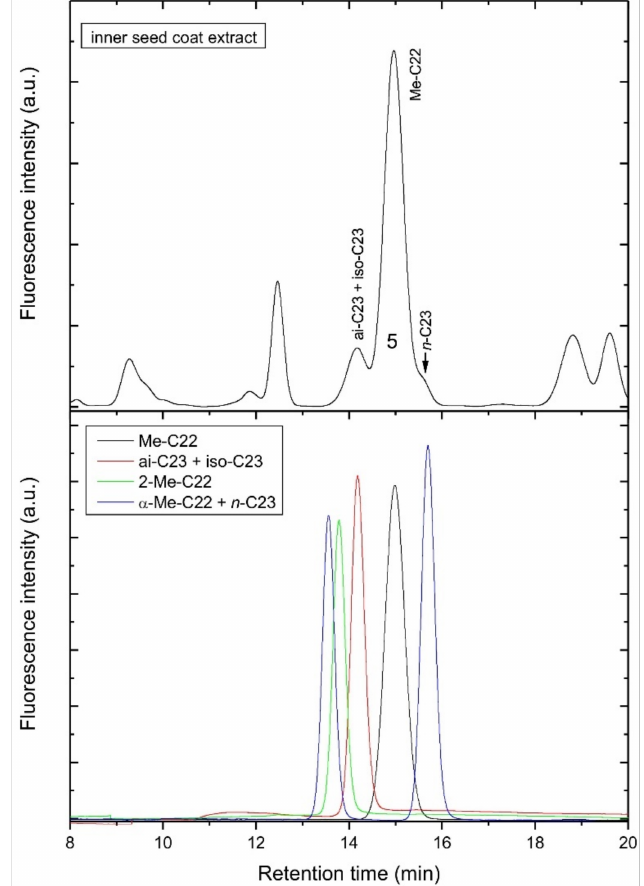
Figure 6. HPLC chromatograms of the inner seed coat extract of lemon ( top ) and various C23- serotonin and C22-methylserotonin standards ( bottom ). Further details are given in the Materials and Methods